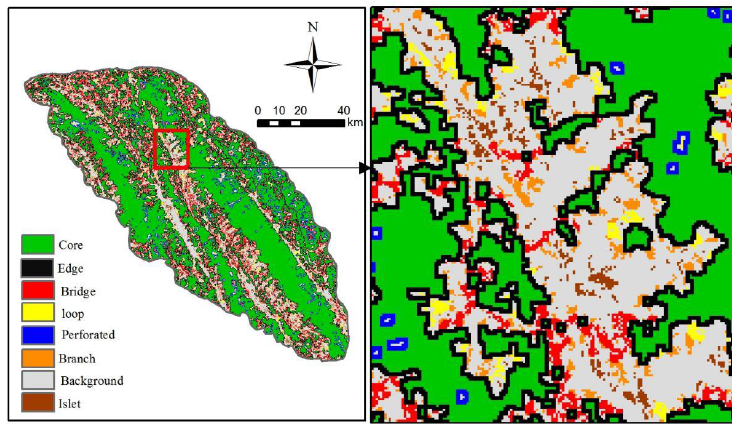
Figure 2. Landscape classification map based on MSPA. Table 2. Area of each landscape type based on MSPA.